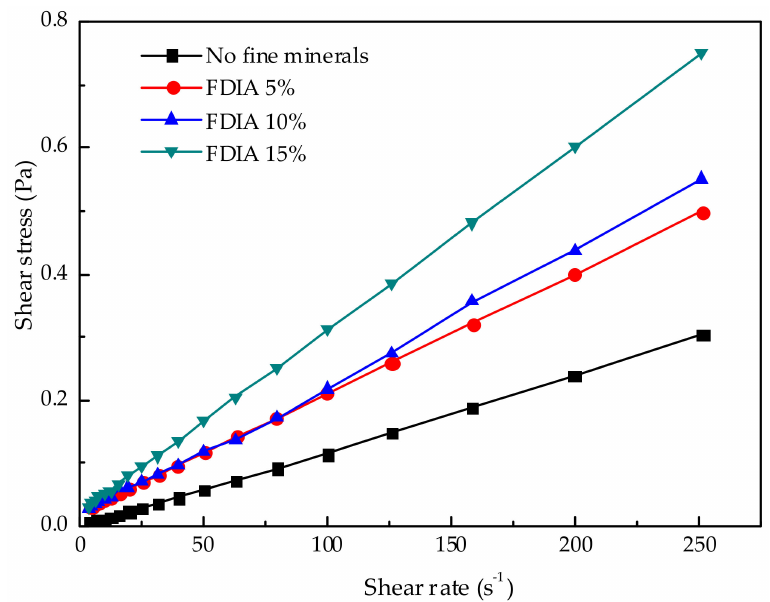
Figure 4. E ff ect of di ff erent FDIA additions on pulp rheology.